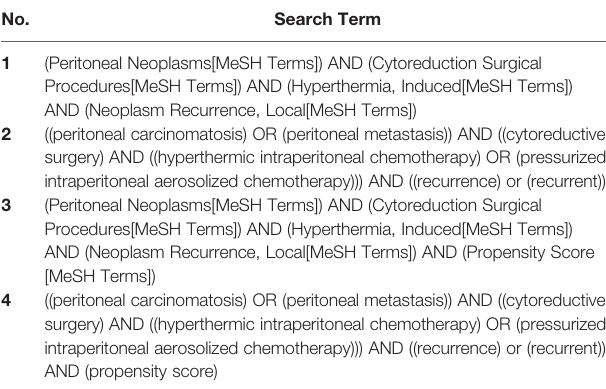
TABLE 1 | Search terms used for literature